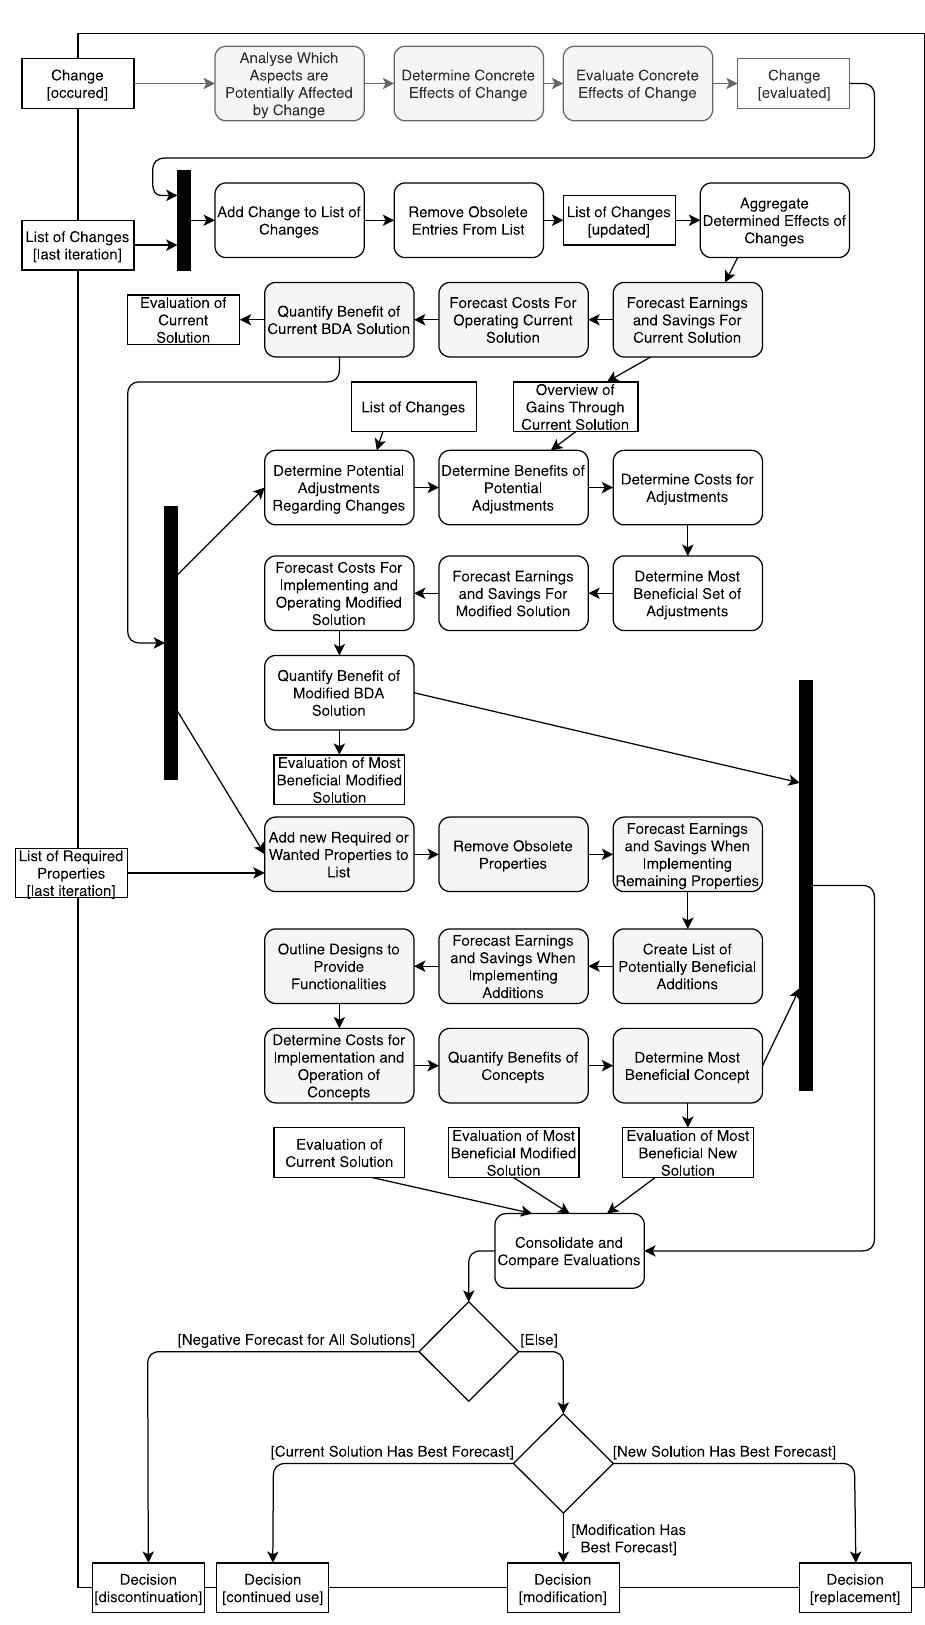
Figure 7. Determining the reaction to the occurrence of a relevant